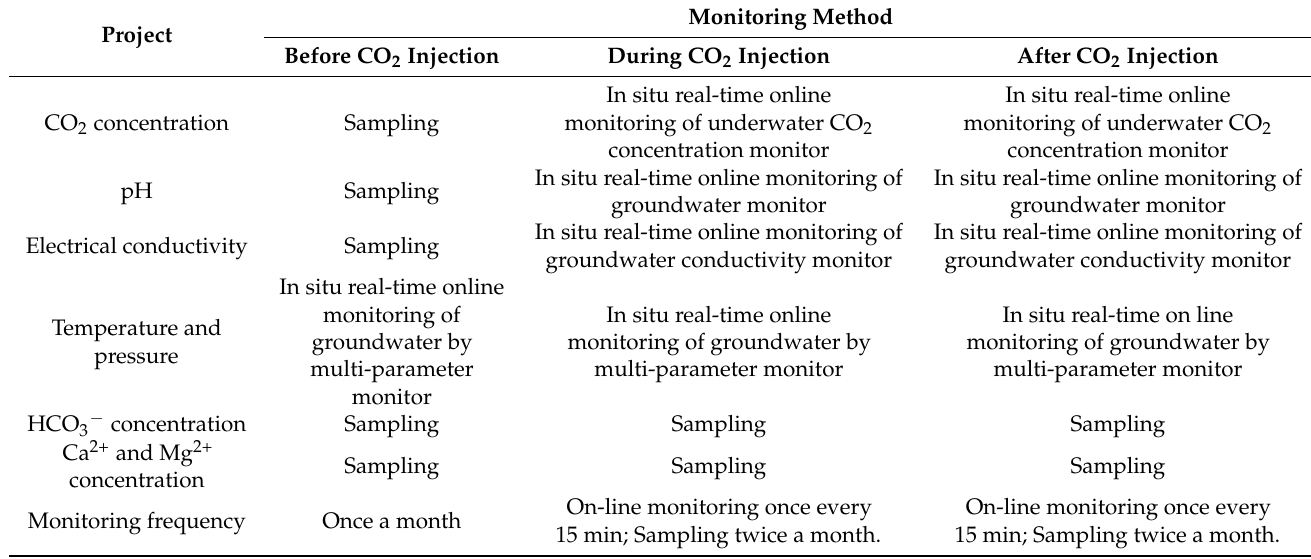
Table 2. Monitoring indexes and methods of groundwater CO 2 leakage